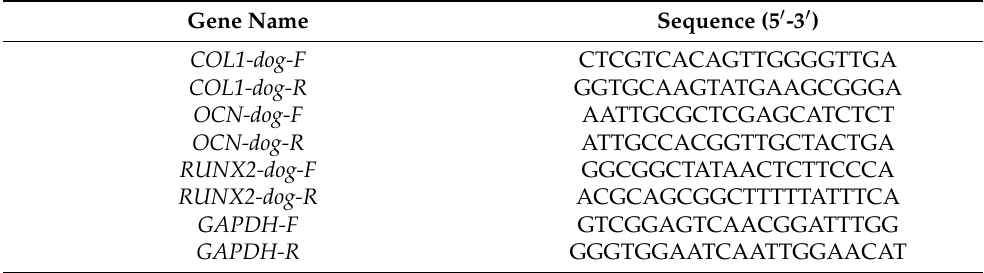
Table 1. Sequences of primers used for reverse transcription–polymerase chain reaction